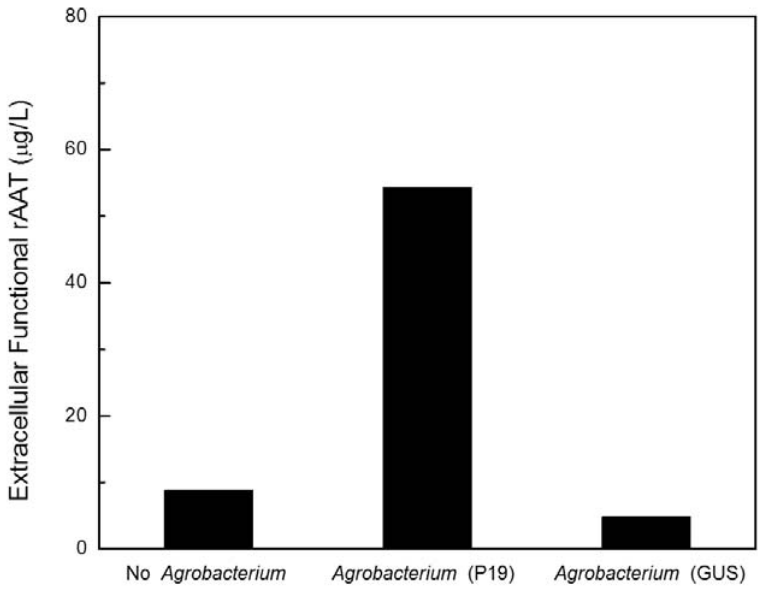
Figure 3. Recombinant human AAT production in transgenic CMViva cell cultures co ‐ cultivated with either recombinant Agrobacterium strain (containing 35S CaMV promoter driving GUS expression) or recombinant Agrobacterium strain carrying the P19 viral gene silencing suppressor in a 6 ‐ well microplate at 20 °C. The biomass ratio of Agrobacterium to plant cells is 125 μ g ‐ DCW/g ‐ DCW. Samples were taken 6 days post ‐ induction.